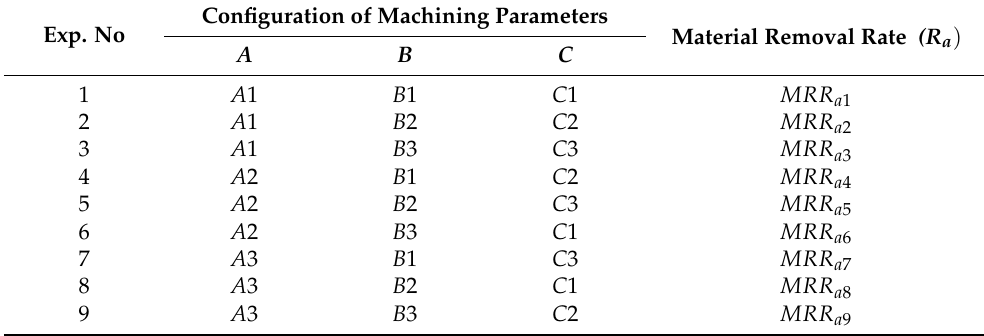
Table 7. Configuration of EP machining